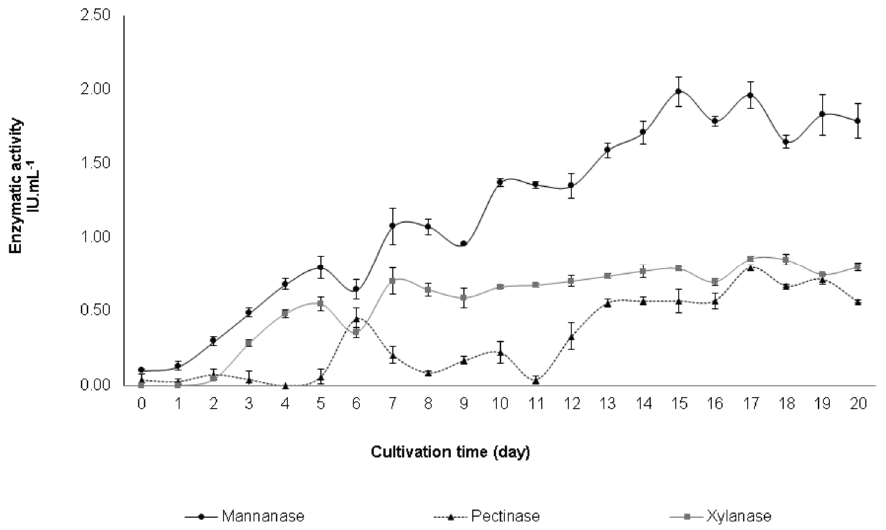
Figure 1. Induction profile of mannanase, pectinase and xylanase activities during growth of Aspergillus foetidus ( A. foetidus ) on soybean